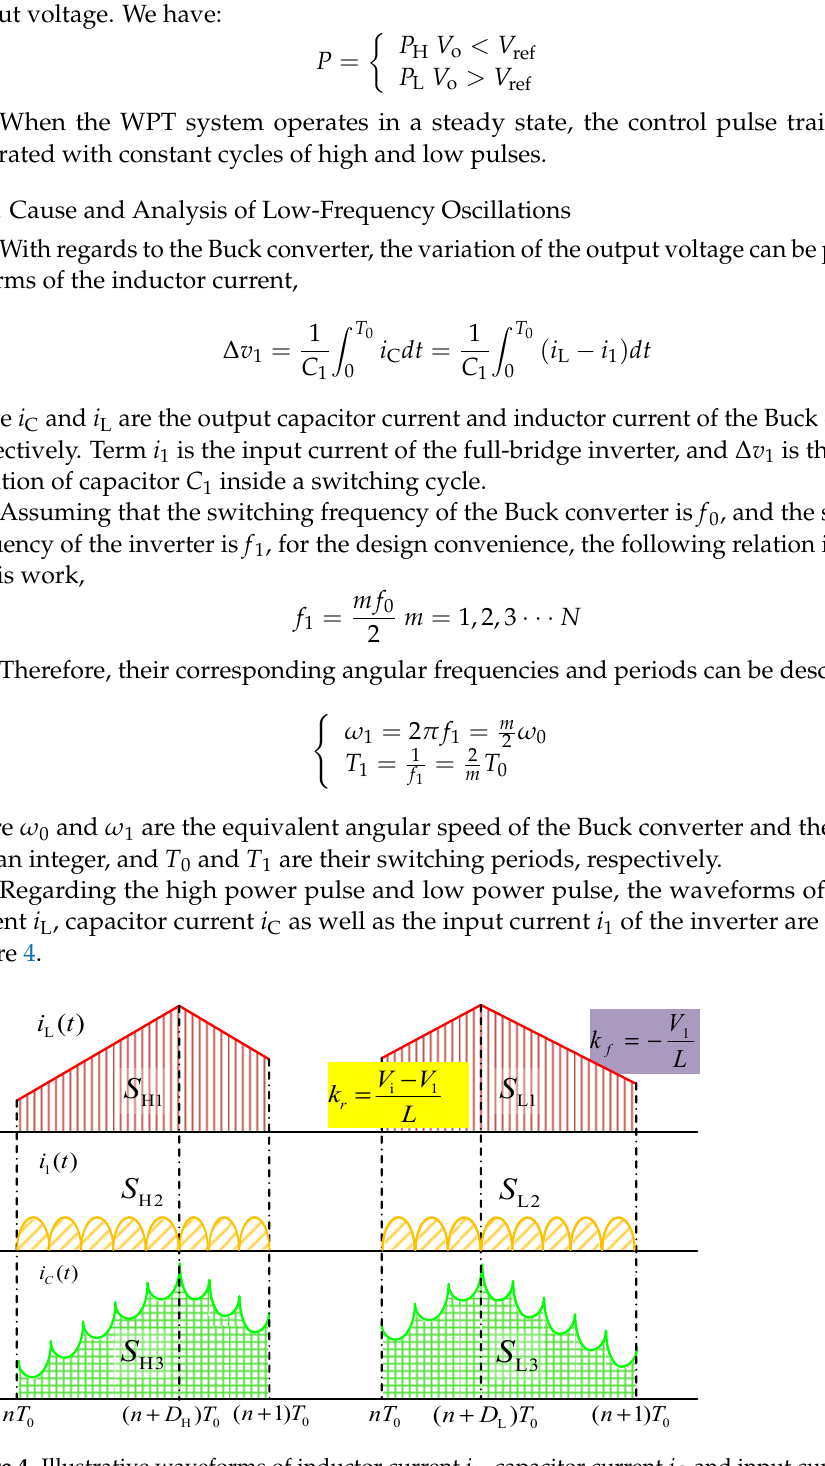
Figure 4. Illustrative waveforms of inductor current i L , capacitor current i C and input current i 1 . The variation slope k v of the inductor current is expressed